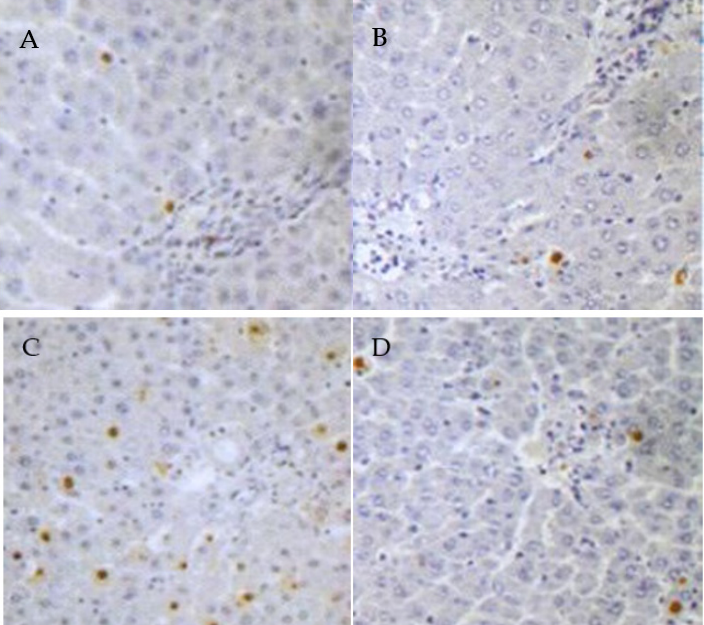
Figure 2. The effects of proanthocyanidins (PCs) on lead ‐ induced liver apotosis. TUNEL ‐ stained liver section (magnification, 200×), with brown granules indicating the positive cells. Mice were divided into the following groups: ( A ) control group; ( B ) PCs group; ( C ) group administrated with lead; ( D ) lead co ‐ treated with PCs at a dose of 100 mg/kg.